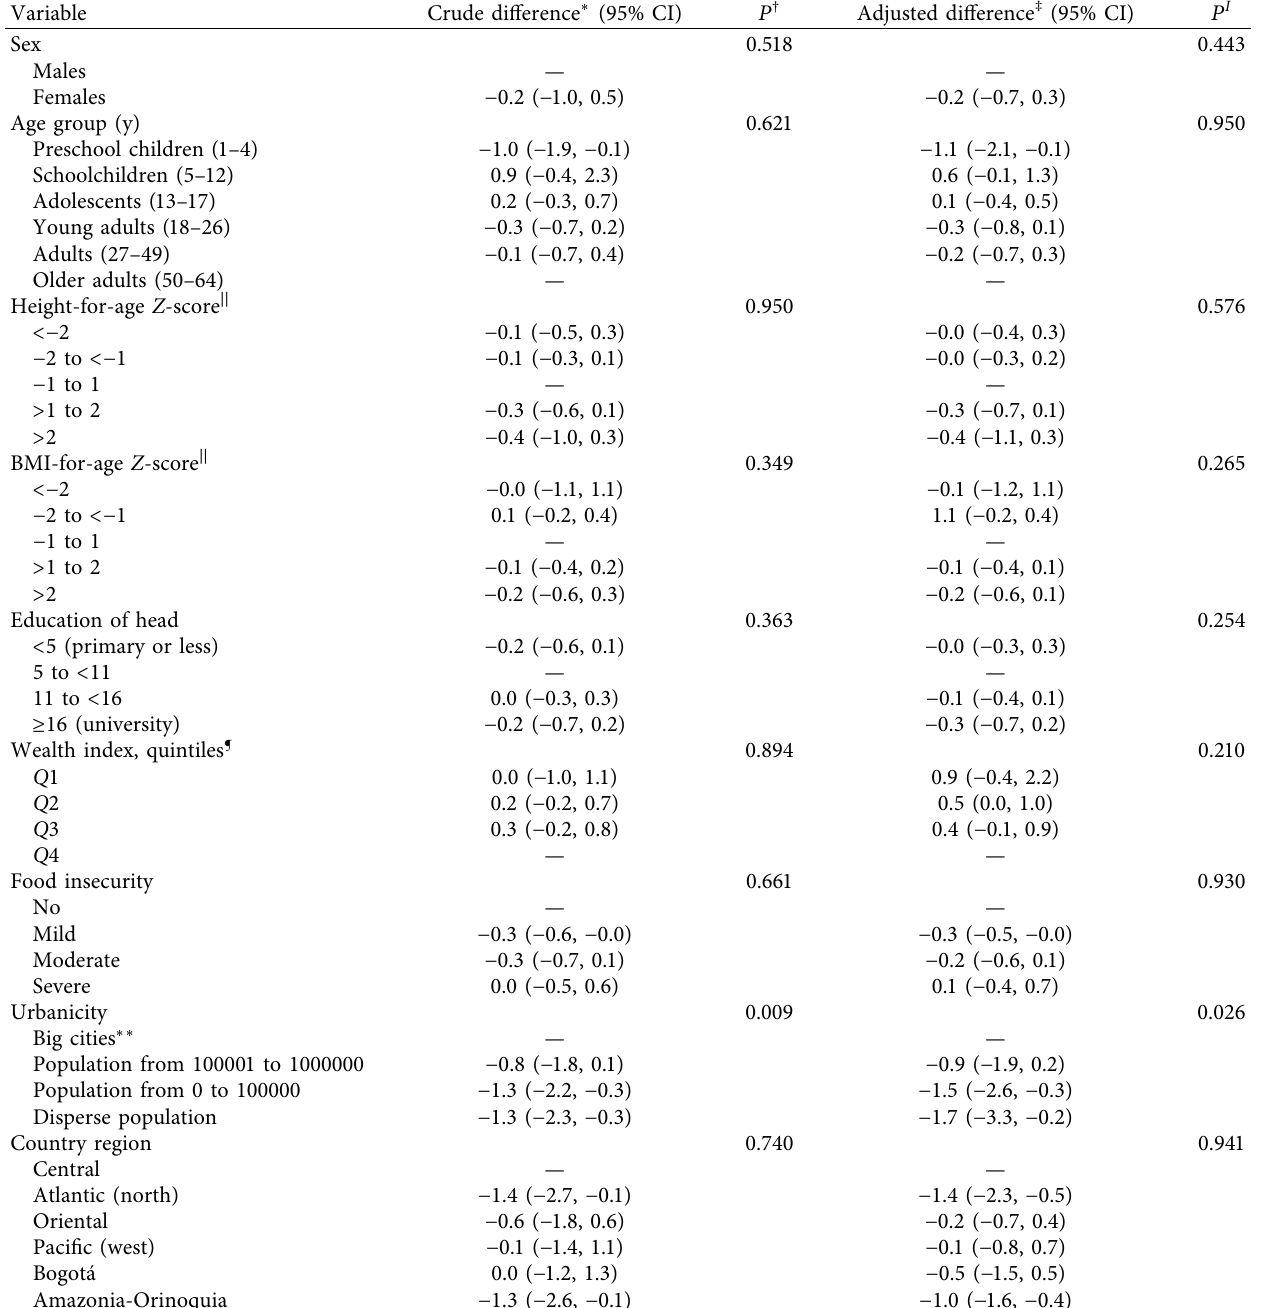
Table 3: Differences in vegetal (plants) protein intake, g/d for every 1000kcal consumed in Colombian population (aged from 1 to 64